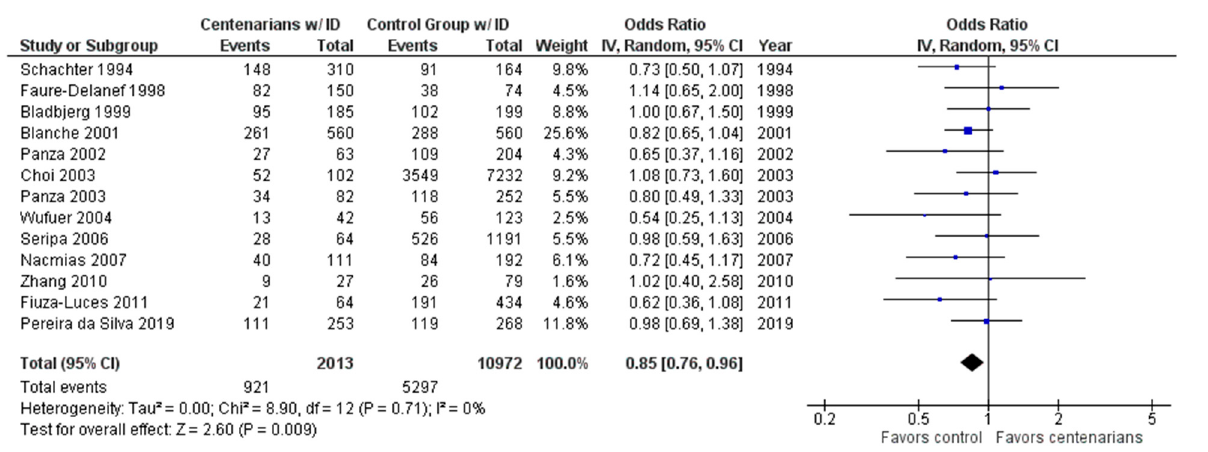
Figure 2. Comparison of DD genotype frequency in centenarians and control groups. The ages of centenarians and control groups are as described in Table 1. The p- value is indicated by P in the Figure.